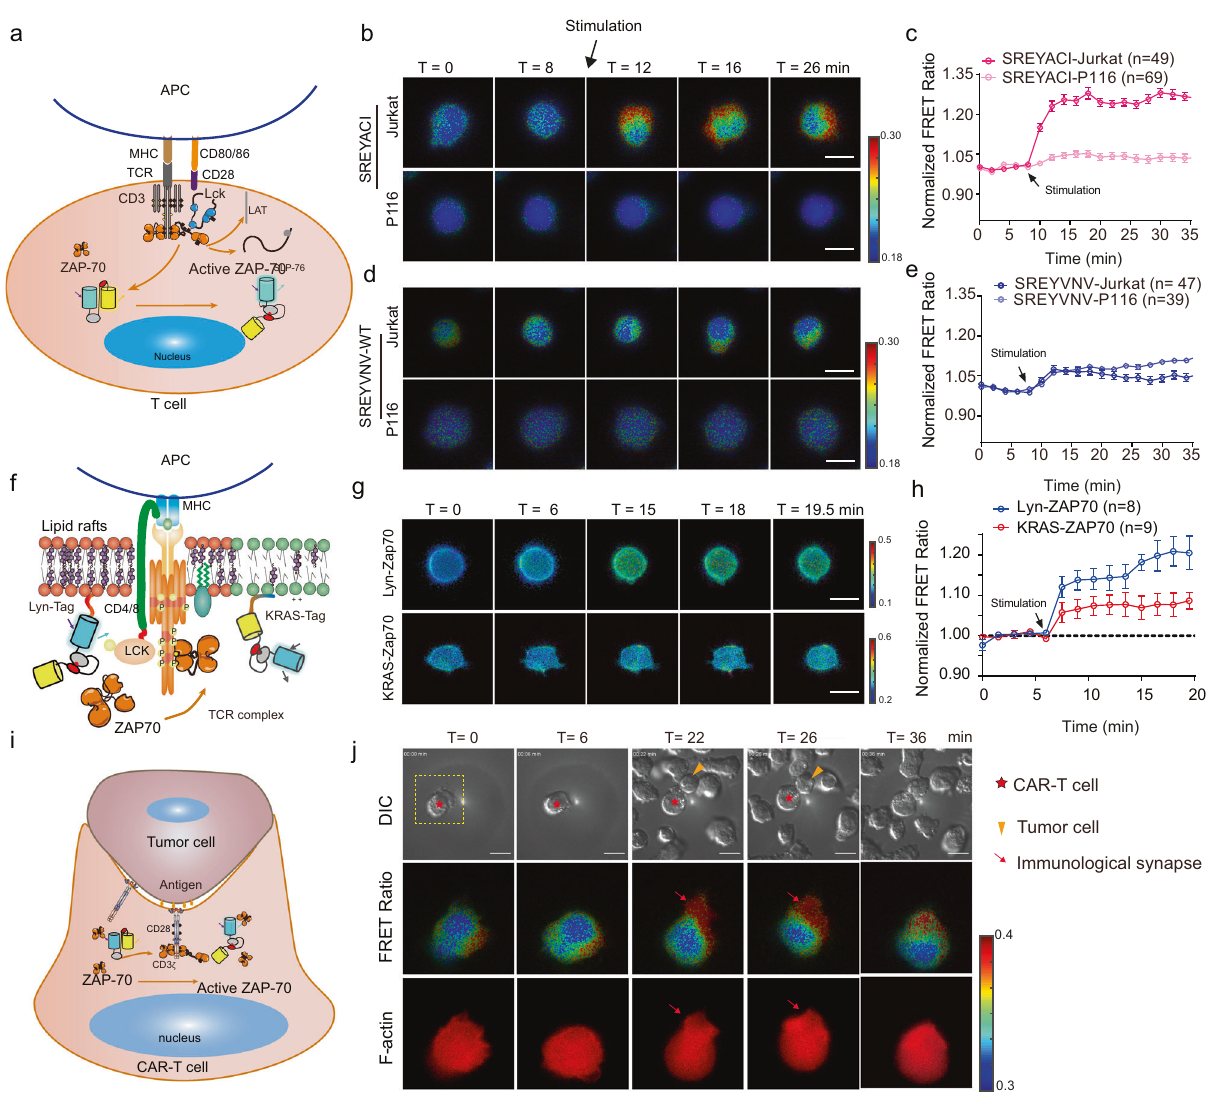
Fig. 4 The sensitivity and speci fi city of the ZAP70 FRET biosensor in human T cell. a Working mechanism of the ZAP70 FRET biosensor in reporting TCR signaling. b – e Time-lapse ECFP/FRET ratio (FRET ratio) images ( b , d ) and time courses ( c , e ) of improved ( b , c ) or parental (WT) ( d , e ) biosensors before and after TCR activation induced by CD3/CD28 antibody stimulation ( n is shown in the fi gure). Error bars, mean ± SEM. Scale bars, 10 µ m. See also supplementary video 5. f Schematics of membrane-bound biosensors which target different membrane compartments. Lyn- and Kras-ZAP70 FRET biosensors target the lipid rafts or non-raft regions, respectively. g – h Time-lapse FRET ratio images ( g ), and the normalized FRET ratio ( h ) of ZAP70 activities in different membrane compartments after TCR activation before and after CD3/CD28 antibody stimulation. ( n is shown in the fi gure). Error bars, mean ± SEM. Scale bars, 10 µ m in ( g . i ). Schematics of CD19-CAR Jurkat T cell engaging with a CD19 + tumor Toledo cell. j Time-lapse FRET ratio images of CAR-T cell expressing the improved ZAP70 FRET biosensor before and after the engagement with a target tumor Toledo cell. Each biological replicate had similar results ( n = 4). Scale bars, 10 µ m. See also supplementary video 6. The color bar in ( b , d , g , j ) indicates FRET ratio (ECFP/FRET), with hot and cold colors representing the high and low ratios, respectively. Source data are provided as a Source Data fi le.